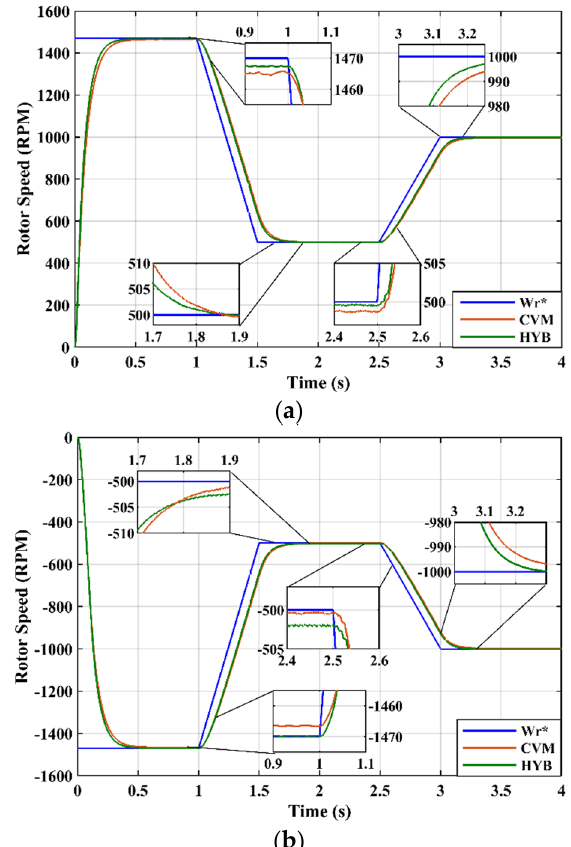
Figure 15. Rotor speed response under variable speed trajectory: ( a ) in forward operation and ( b ) in reverse operation.